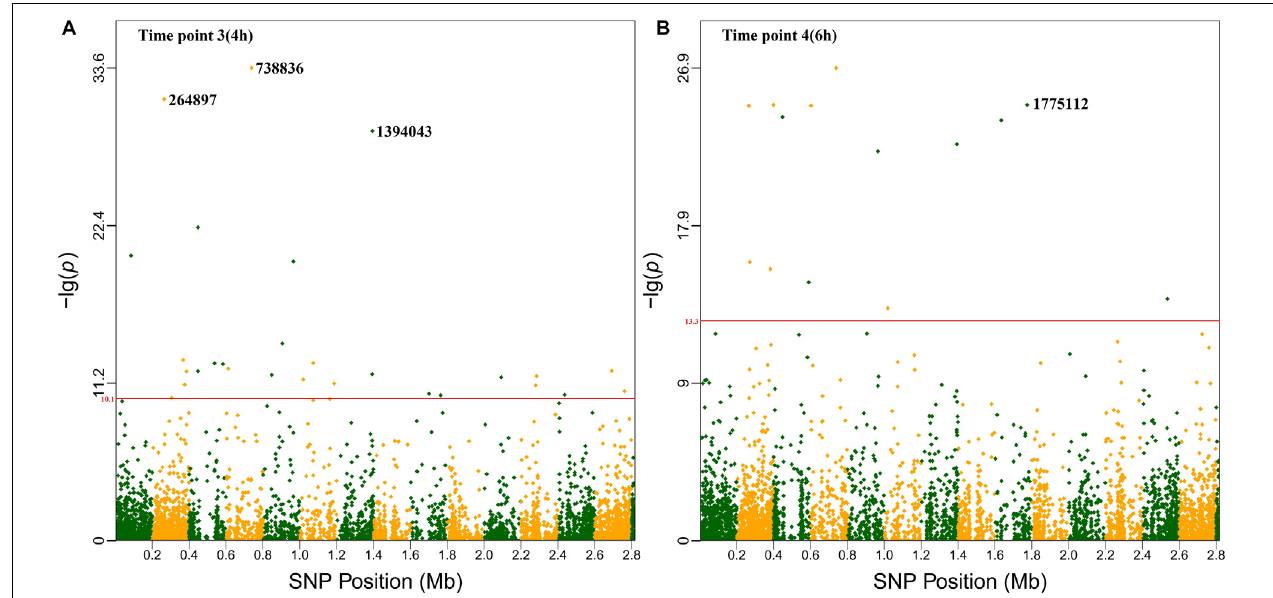
FIGURE 4 | Manhattan plots of the four significant SNPs The x -axis showed SNP positions (Mb) and the y -axis was the –log P -value resulting from the association test. Each dot in the plot represented an SNP, and a reference line was used on the y -axis to reflect genome-wide significance. (A) Time point 3 (4 h). (B) Time point 4 (6 h).